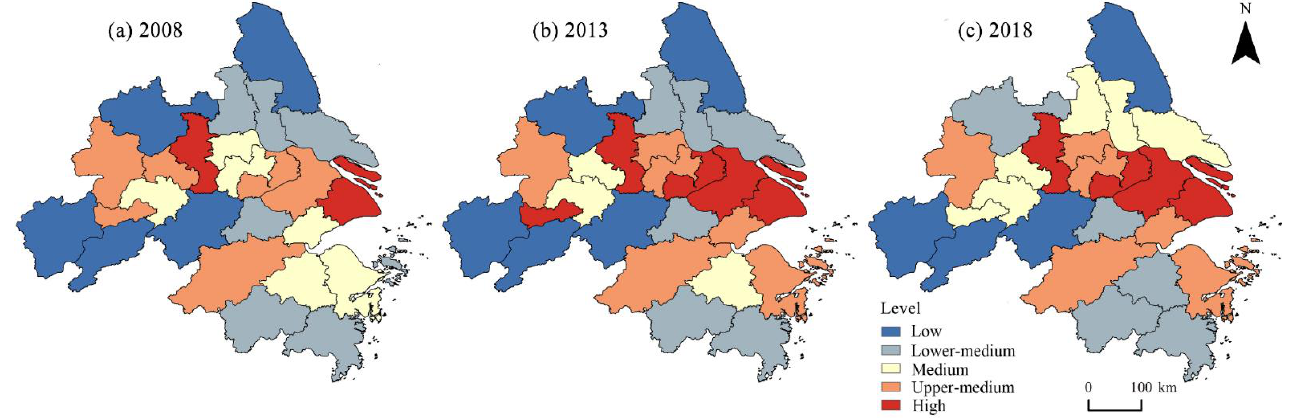
Figure 4. Spatial and temporal patterns of urbanization in the Yangtze River Delta in 2008 ( a ), 2013 ( b ), and 2018 ( c ).